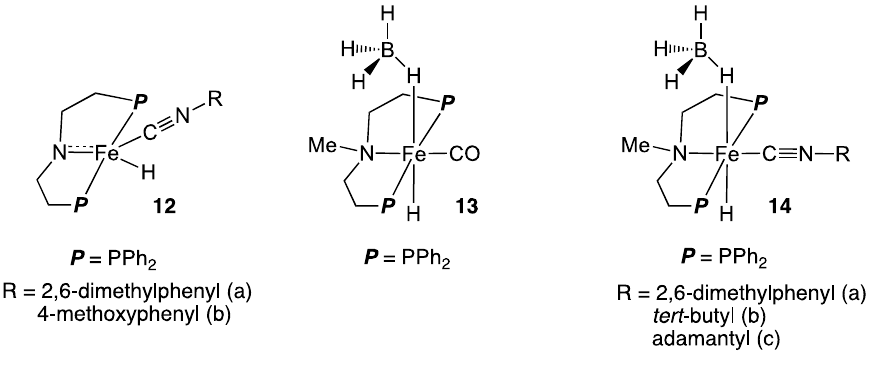
Figure 3. Depiction of catalysts 12–14 .